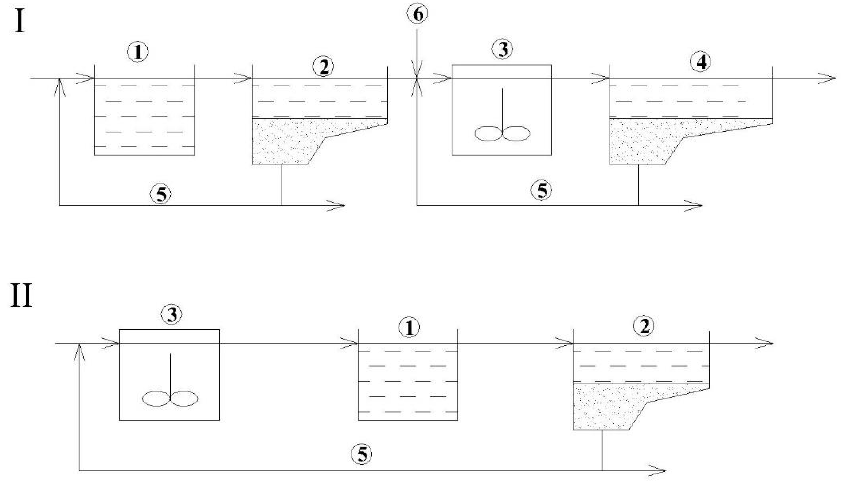
Figure 2. Two-stage nitrification/denitrification (N/D) systems: 1 — ASRN; 2 — SC; 3 — Active sludge